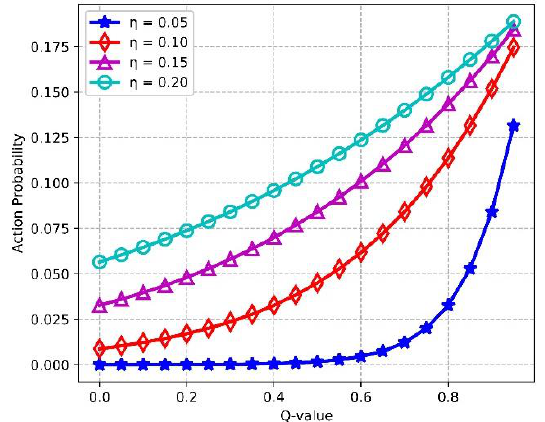
Figure 16. Action probability vs. Q-value.